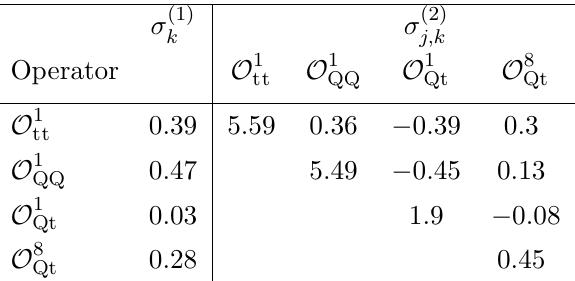
and (cid:27) (2) , of eq. (6.3). k j;k